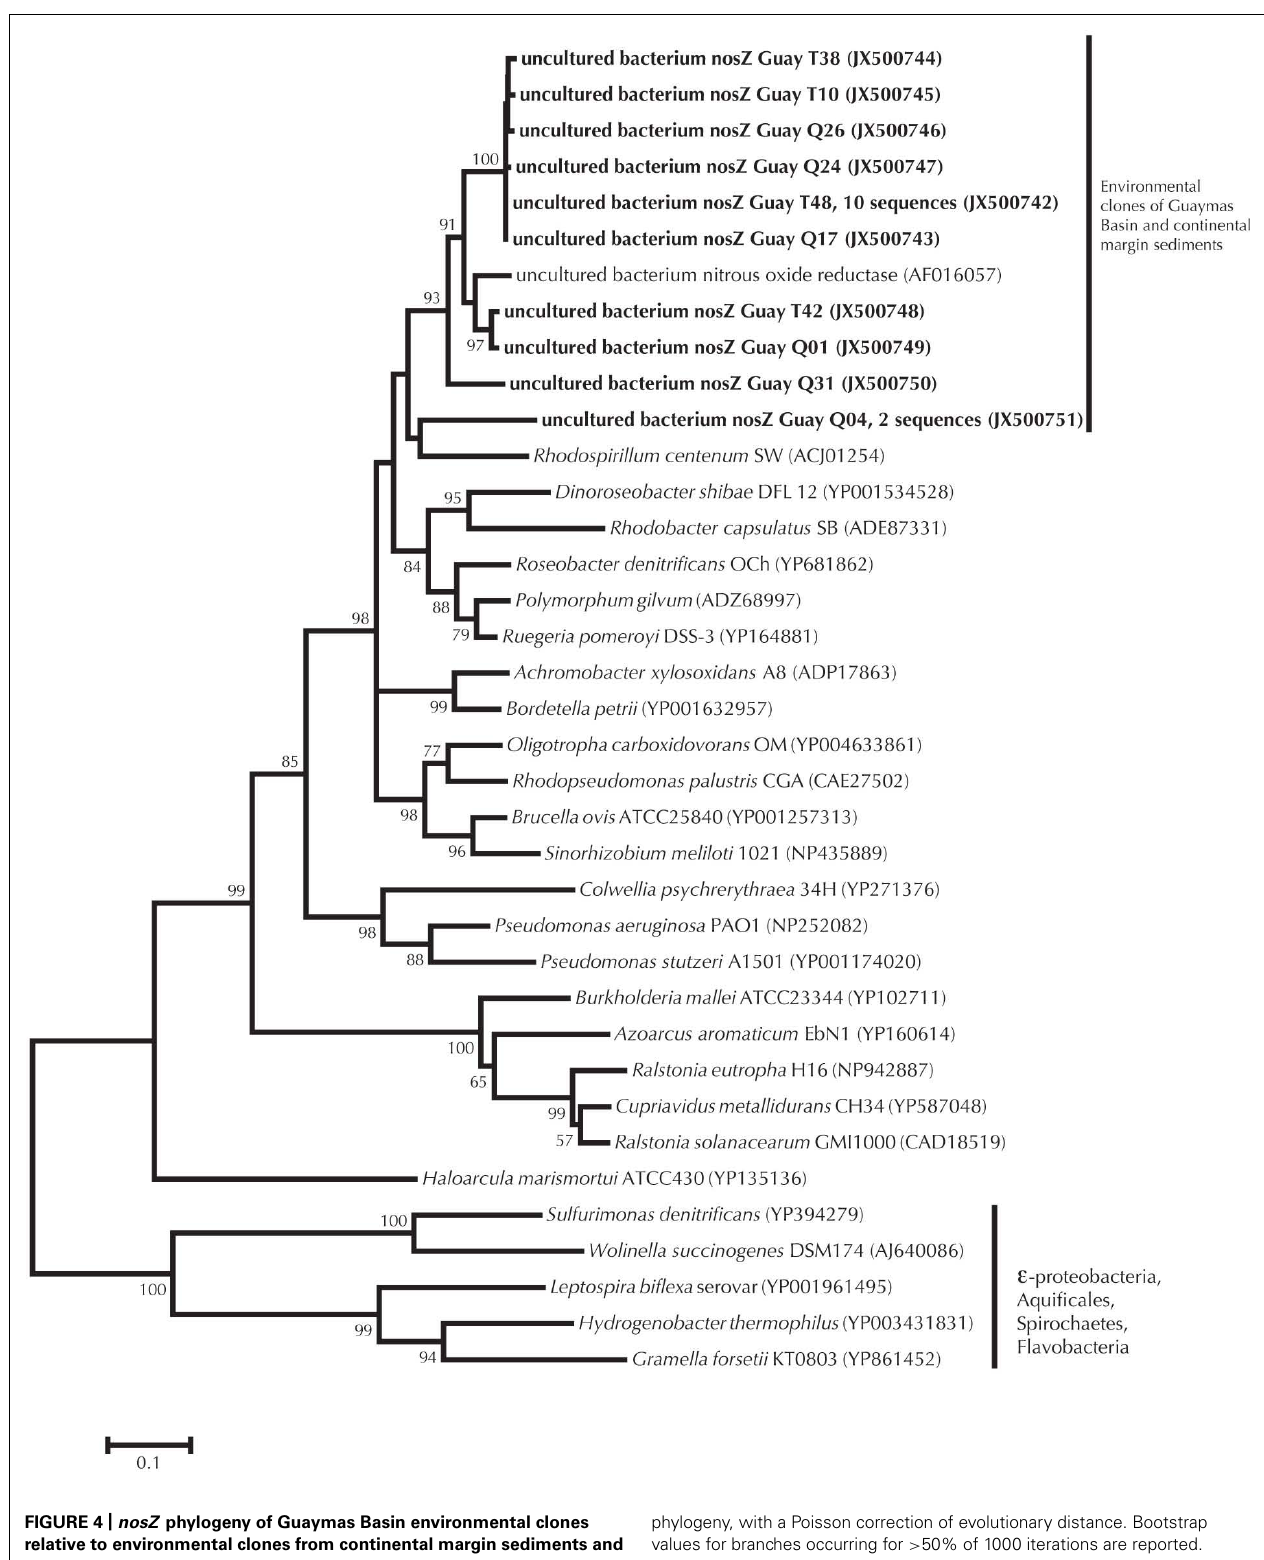
phylogeny, with a Poisson correction of evolutionary distance. Bootstrap values for branches occurring for > 50% of 1000 iterations are reported. Scaling of the phylogenetic tree is based on an evolutionary distance of